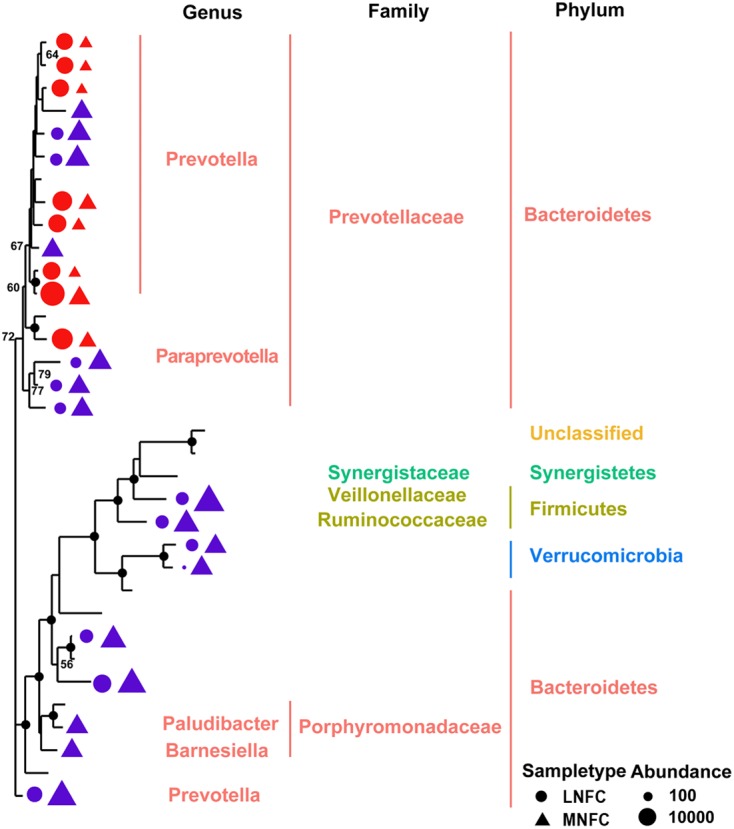
Maximum likelihood tree of 34 detectable OTUs (relative abundance > 1% for a given sample). The complete 16S rRNA gene sequences of the corresponding species in the RDP database were used to construct the tree. Triangle indicates the OTUs in the MNFC group, and the circle indicates the OTUs in the LNFC group. Only the OTUs with significant differences (p < 0.05) in relative abundance are shown behind the branches. The size of the symbol indicates the relative abundance of OTUs. Blue indicates a significant expansion (p < 0.05) of the relative abundance of the OTU after a 31% NFC diet, and red indicates a significant reduction (p < 0.05) in the relative abundance of the OTU after a 31% NFC diet. The bootstrap values are shown on the tree. The solid black circles at the nodes stand for the bootstrap value of 100.